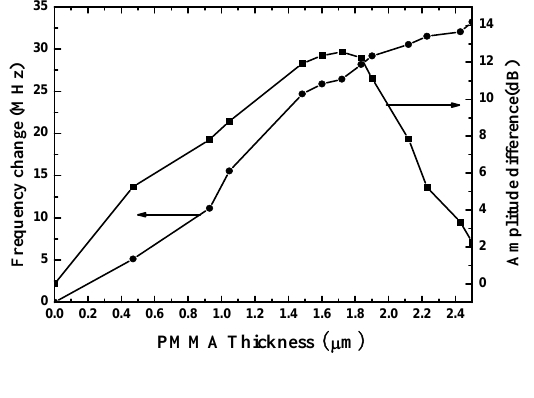
Figure 10. The changes of the resonance frequency and the amplitude of the reflection as a function of PMMA coefficient S 11